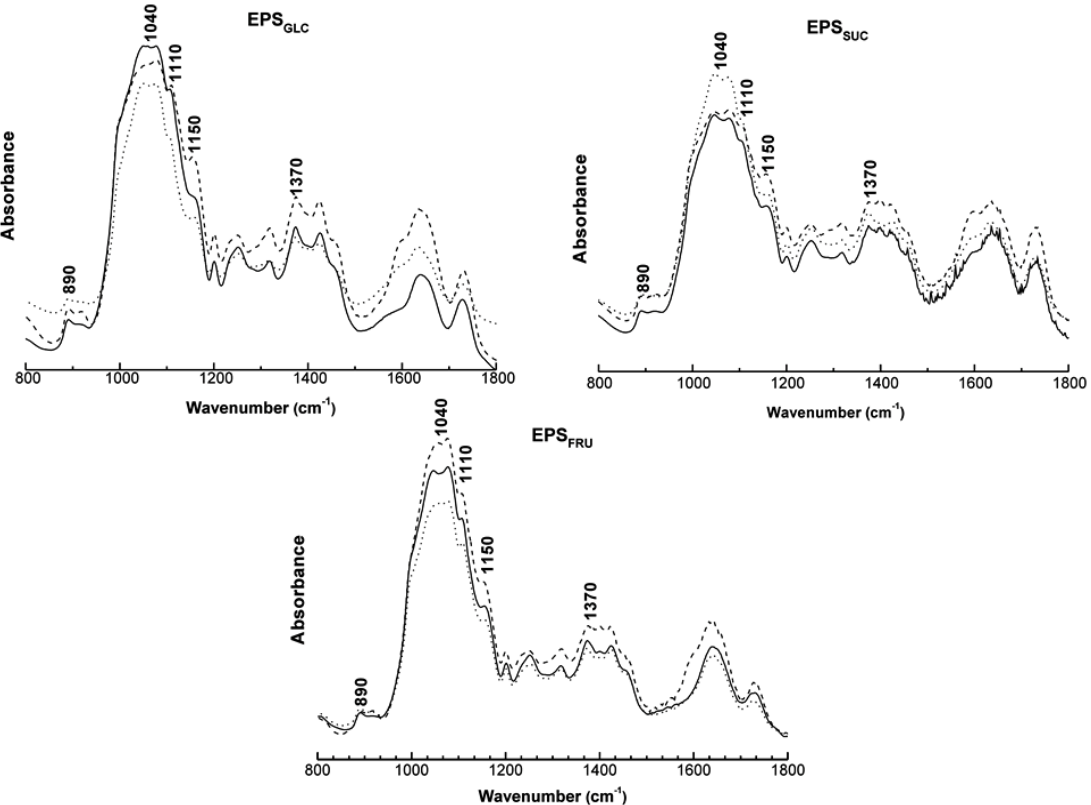
Figure 3. FT-IR Spectra for botryosphaerans EPS (---), after TG ( ___ ) and after DSC ( …. ), showing the characteristic bands of glucosidic